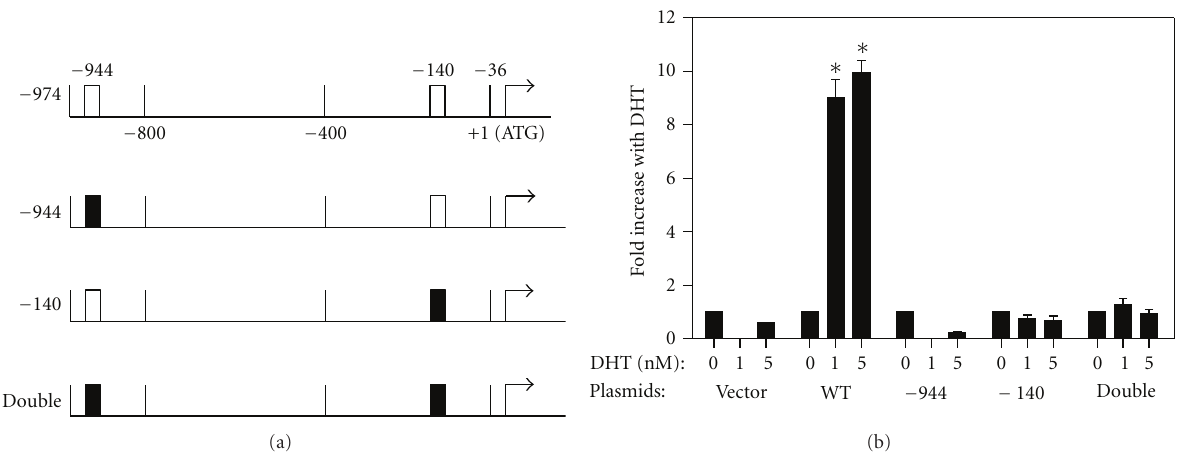
Figure 4: Two functional AREs are present in the tcf8 5 (cid:3) -flanking region. (a) Two well-conserved AREs were identified in tcf8 at − 944 and − 140 (white boxes) relative to the translation start site. Plasmids were constructed in which each of the putative AREs was mutated individually or both were mutated (black boxes). − 36 is the putative transcription start site and is numbered relative to the translation start site. (b). The plasmids depicted in (a) were transfected into PC-3/AR cells with increasing concentrations of DHT as indicated. The cells were harvested after 24 hrs and the β -galactosidase activity in the lysates was determined. ∗ P < 0 . 05 relative to no DHT. n = 6 with 2-3 replicates per experiment.